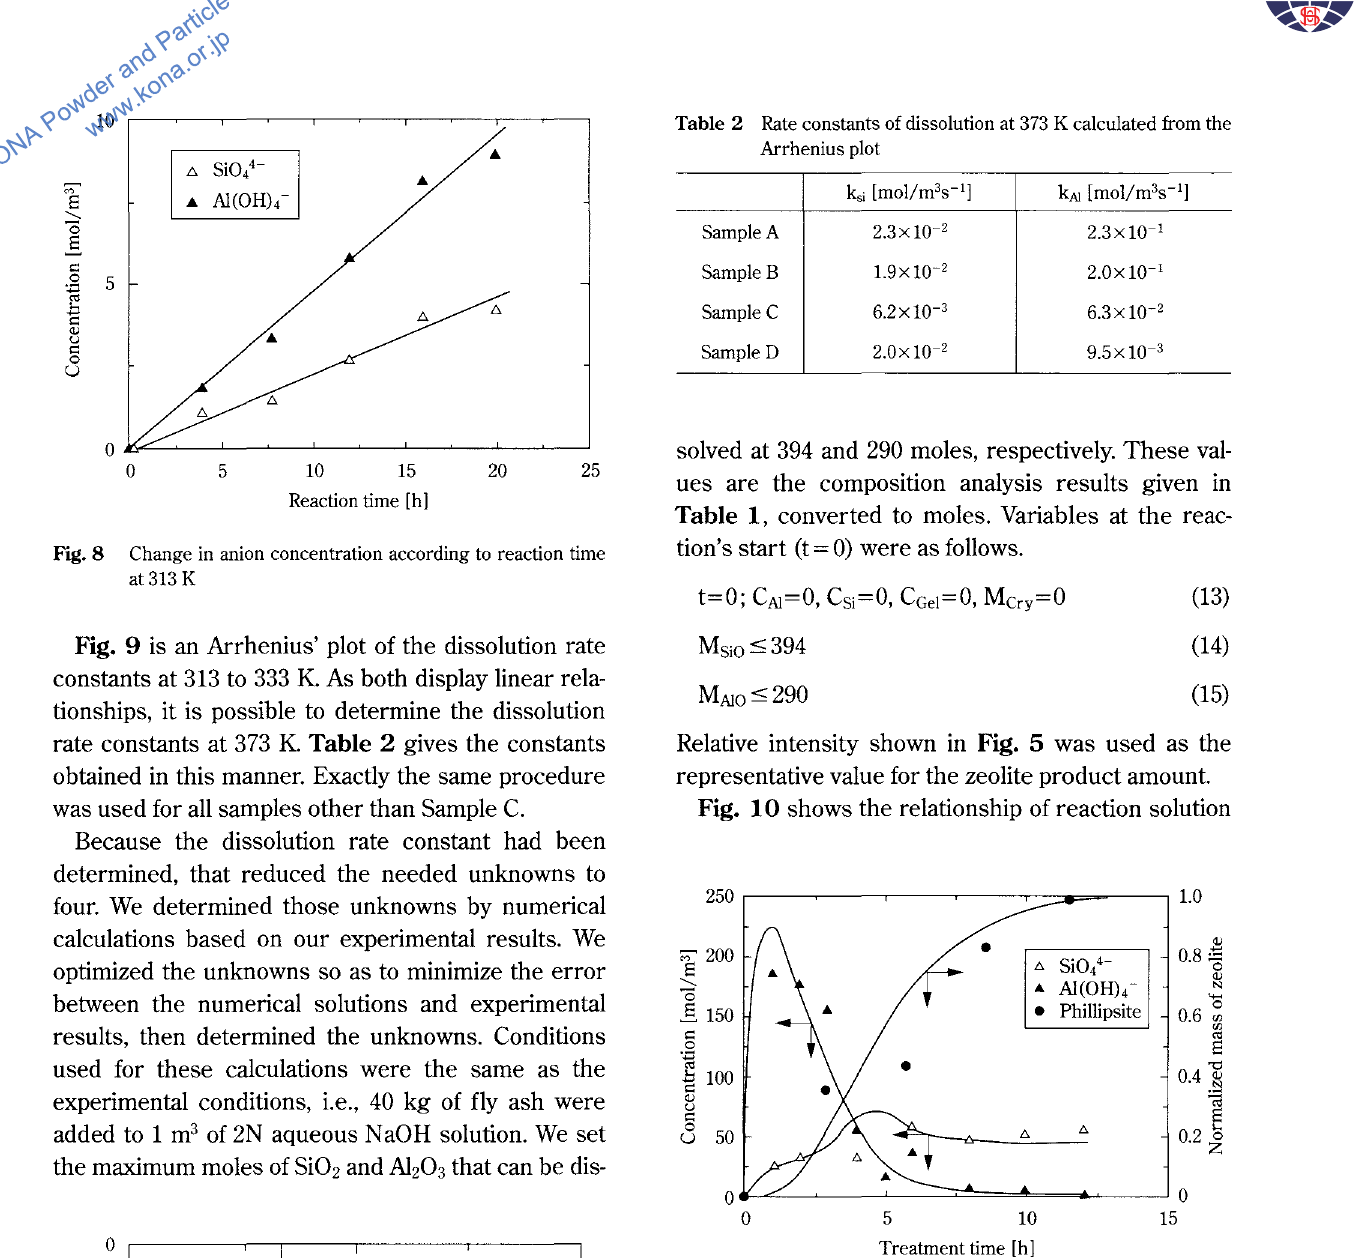
0.004 Fig. 10 Comparison between experimental and calculated results for concentration and normalized mass change